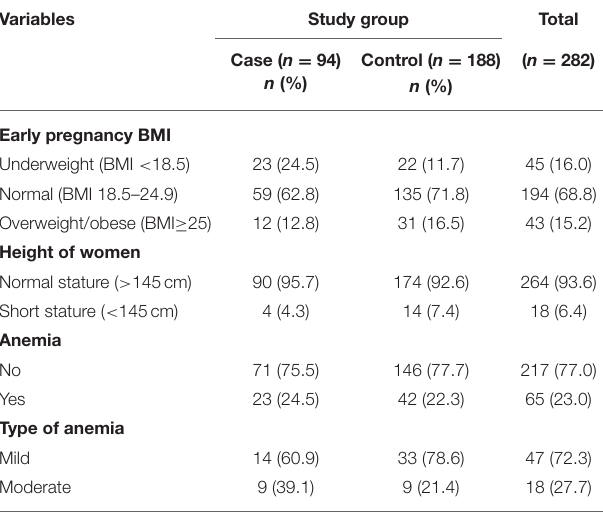
TABLE 5 | Nutritional status of the study participants. TABLE 6 | Behavioral and environmental characteristics among the study